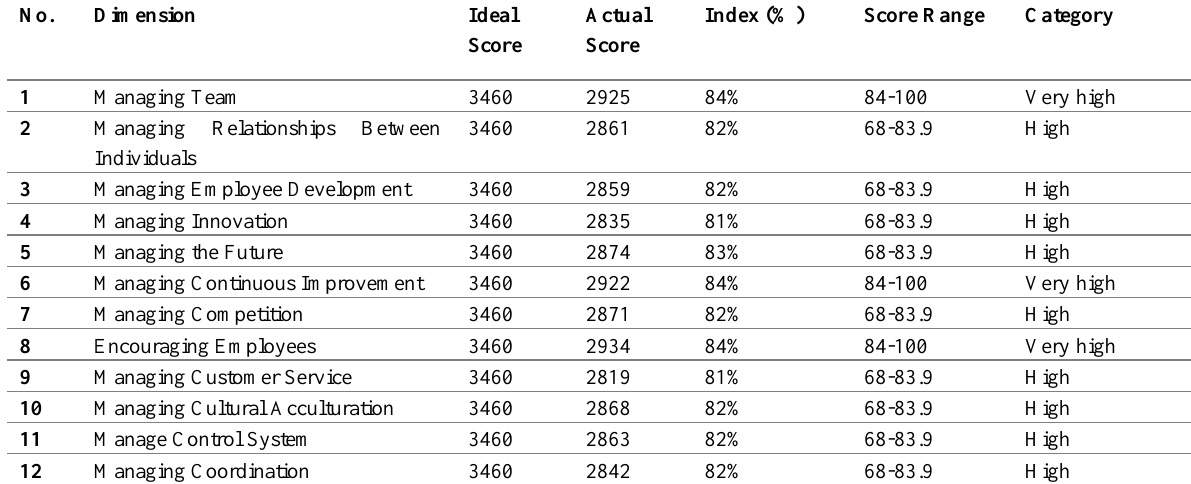
Table 10: Description of Managerial Competencies